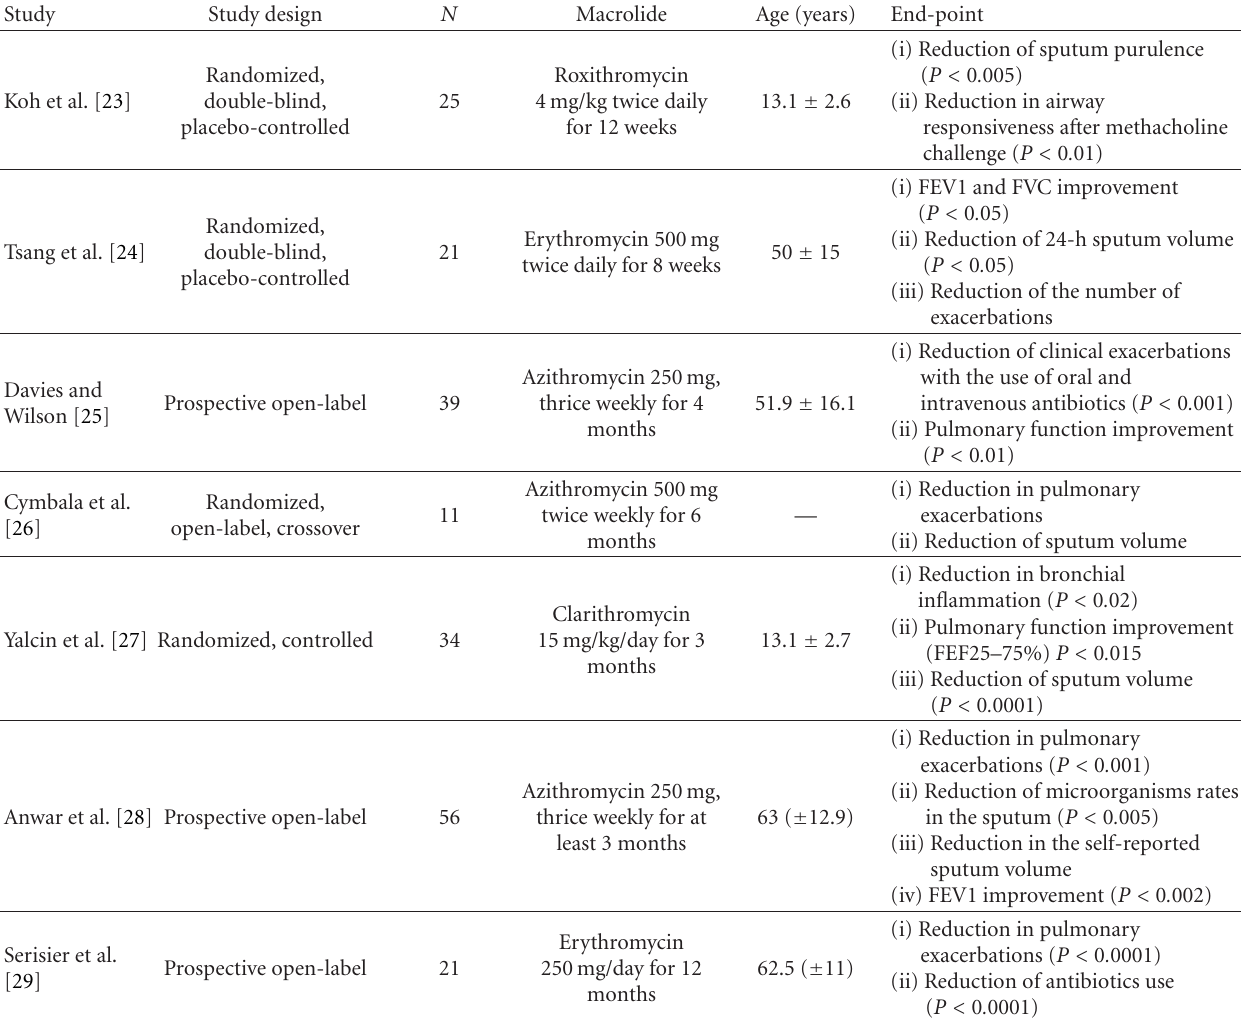
Table 1: Macrolides in noncystic fibrosis